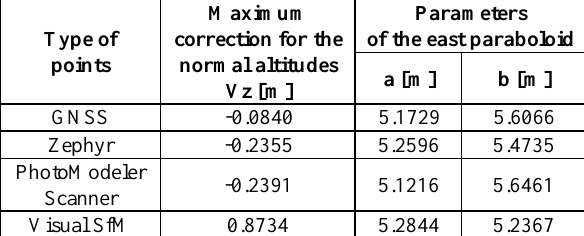
Table 6. The parameters a and b of the hyperbolic paraboloid created based on the roof point clouds